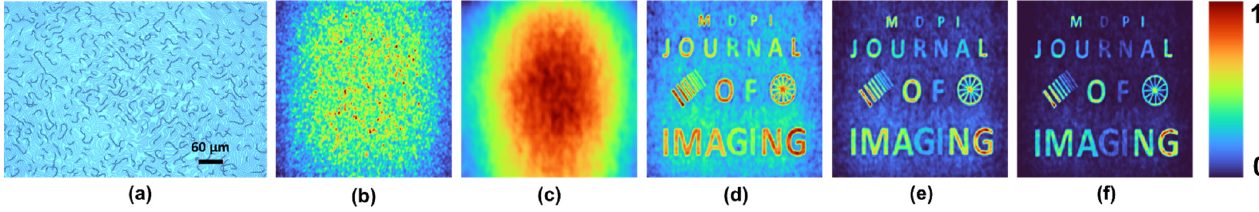
Figure 7. ( a ) Optical microscope image of the central part of the QRL fabricated using electron-beam lithography. ( b ) Recorded PSF, ( c ) object’s response pattern. Reconstruction results using ( d ) NLR ( p = 1), ( e ) NLR ( p = 2) and ( f ) NLR ( p = 3).